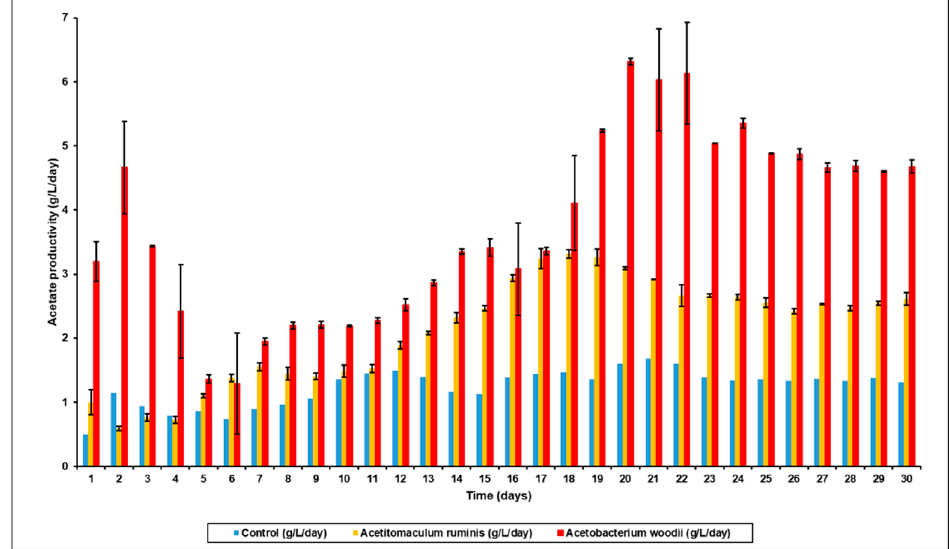
Figure 5. Acetate productivity (g/L/day) in control bioreactor after BES addition versus that bioaugmented with A. ruminis and A. woodii .